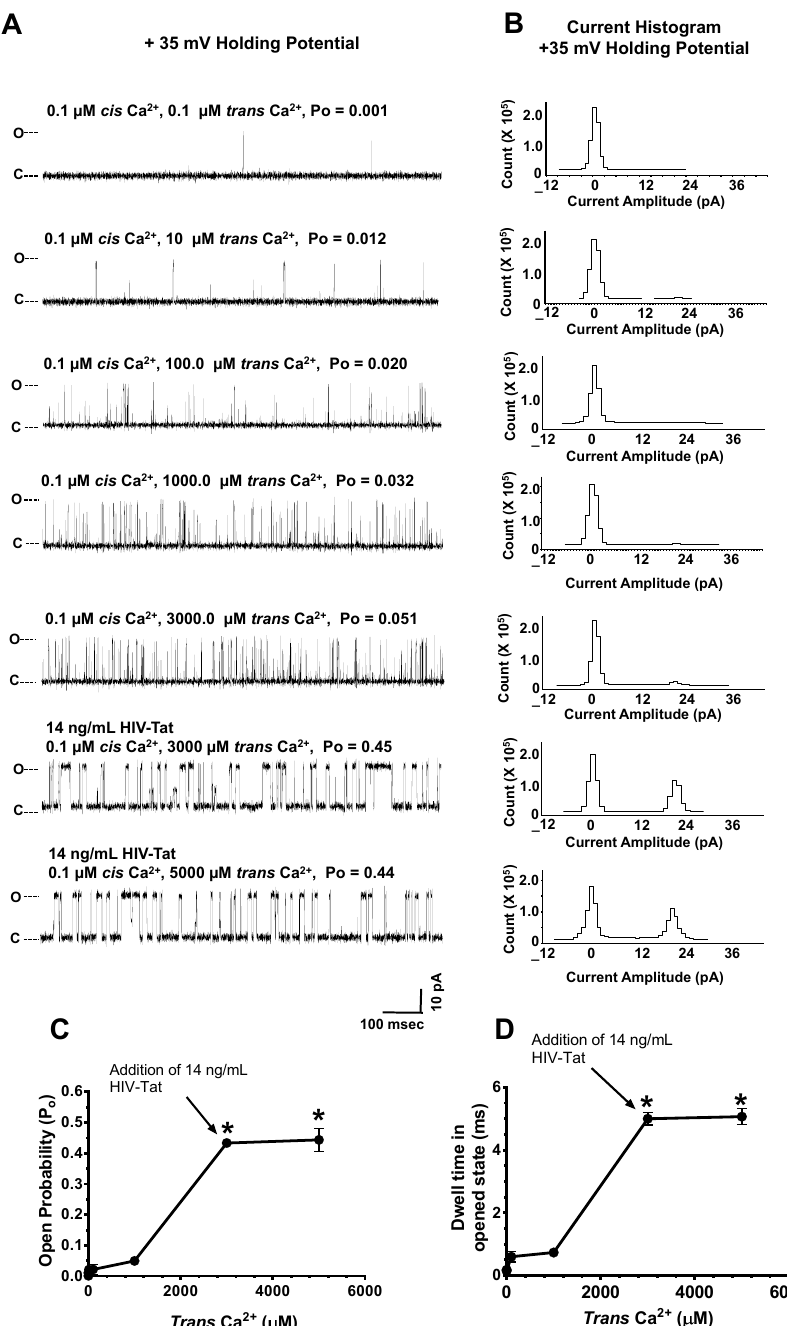
Figure 7. Effects of luminal Ca 2+ and cis HIV-Tat on the open probability of RyR2. Panel A shows a representative 1.0 s recording of a RyR2 channel with 0.1 μ M cis Ca 2+ and increasing amounts of trans Ca 2+ . The lower two recordings occurred with 14 ng/mL cis HIV-Tat with 3000 μ M and 5000 μ M trans Ca 2+ . Panel B shows the current histograms for the channel with cumulative amounts of cis EFV. Panels C , D are graphs of the open probability and dwell time (mean ± SD) of RyR2 as a function of the cis concentrations of the HIV-Tat channels for n = 12 channels. Recordings shown are at +35 mV (upward deflections) in a symmetric KCl buffer solution (0.25 mM KCl; 20 mM K/HEPES; pH 7.4). O, open; C, closed. * denotes significantly different ( p < 0.05) from the control (before the addition of the